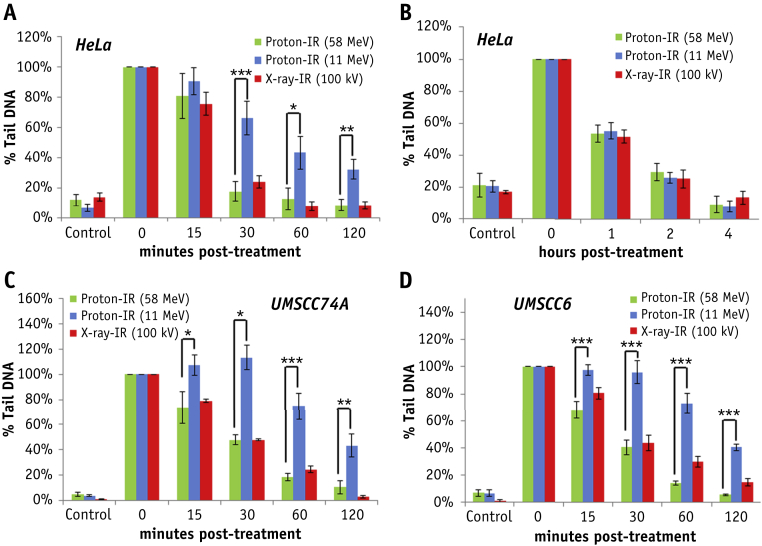
High linear energy transfer (LET) protons induce DNA single-strand breaks (SSBs) and alkali-labile site-associated DNA damage, which displays slow repair kinetics. (A) HeLa, (C) UMSCC74A, or (D) UMSCC6 cells were irradiated with 1.5 Gy X rays or protons at low or high LET and SSBs/alkali labile sites measured at various time points after ionizing radiation (IR) by the alkaline comet assay. (B) HeLa cells were irradiated with 4 Gy IR and DNA double-strand breaks measured at various time points after IR by the neutral comet assay. Shown is the percent tail DNA ± standard deviation normalized to the levels seen immediately after IR, which was set to 100%. *P < .005, **P < .002, ***P < .001, as analyzed by a one-sample t test.